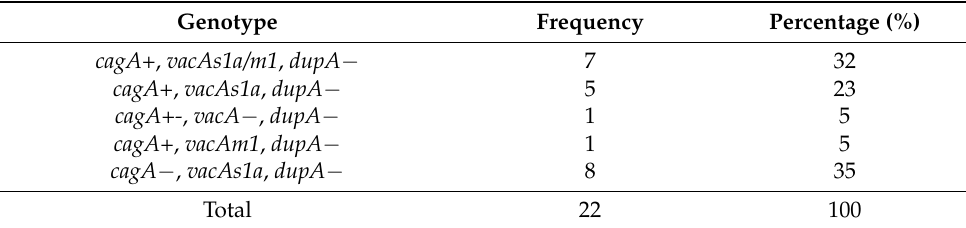
Table 5. Frequency and percentage of genotypes of vaginal intrayeast H. pylori cells according to the amplification of the virulence genes cagA, vacA and dupA.